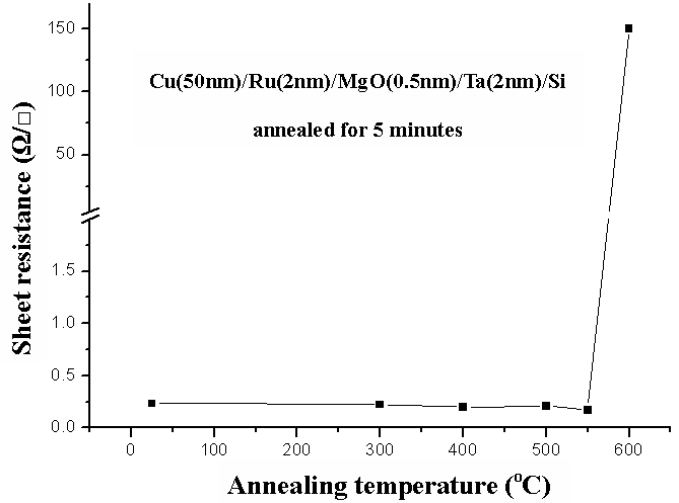
Figure 14. Relation between sheet resistances and annealing temperatures for the Cu (50 nm)/Ru (2 nm)/MgO (0.5 nm)/Ta (2 nm)/Si structures annealed for 5